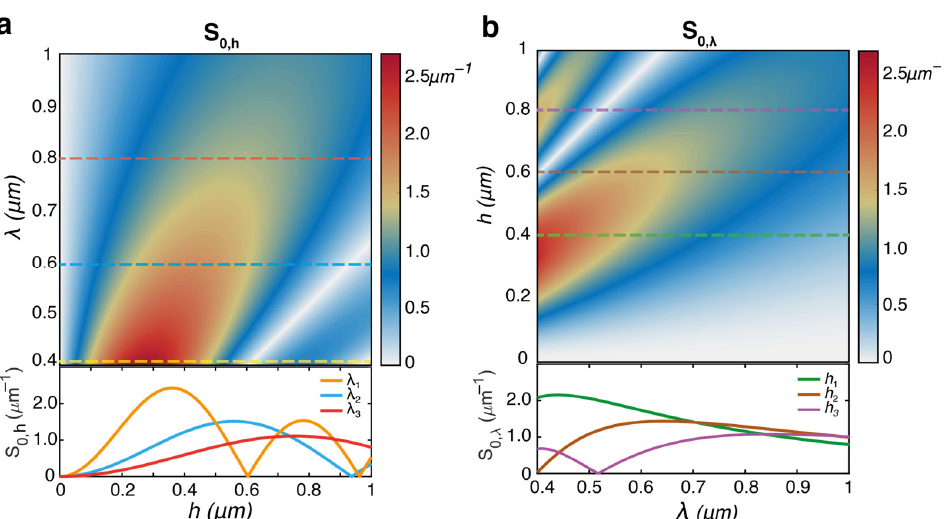
Figure 5. Simulated parametric diffraction sensitivity for PMMA in the 0-order of a sinusoidal surface relief grating. ( a ) Sensitivity S 0, h ( h , λ ) of the efficiency variations to the parameter h . The plot shows the horizontal cross-sectional profiles (dashed lines) of the sensitivity S 0, h ( h ) at λ 1 = 0.4 µ m (yellow), λ 2 = 0.6 µ m (blue), and λ 3 = 0.8 µ m (red). ( b ) Sensitivity S 0, λ to the parameter λ . The cross-sectional profiles for S 0, λ ( λ ) are calculated for h 1 = 0.4 µ m (green), h 2 = 0.6 µ m (brown), and h 3 = 0.8 µ m